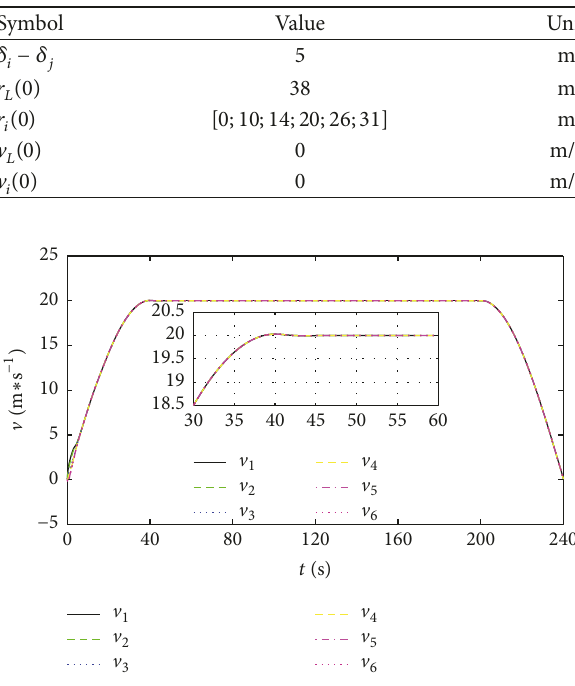
Figure 2: Velocities of vehicles with actuator saturation in vehicle